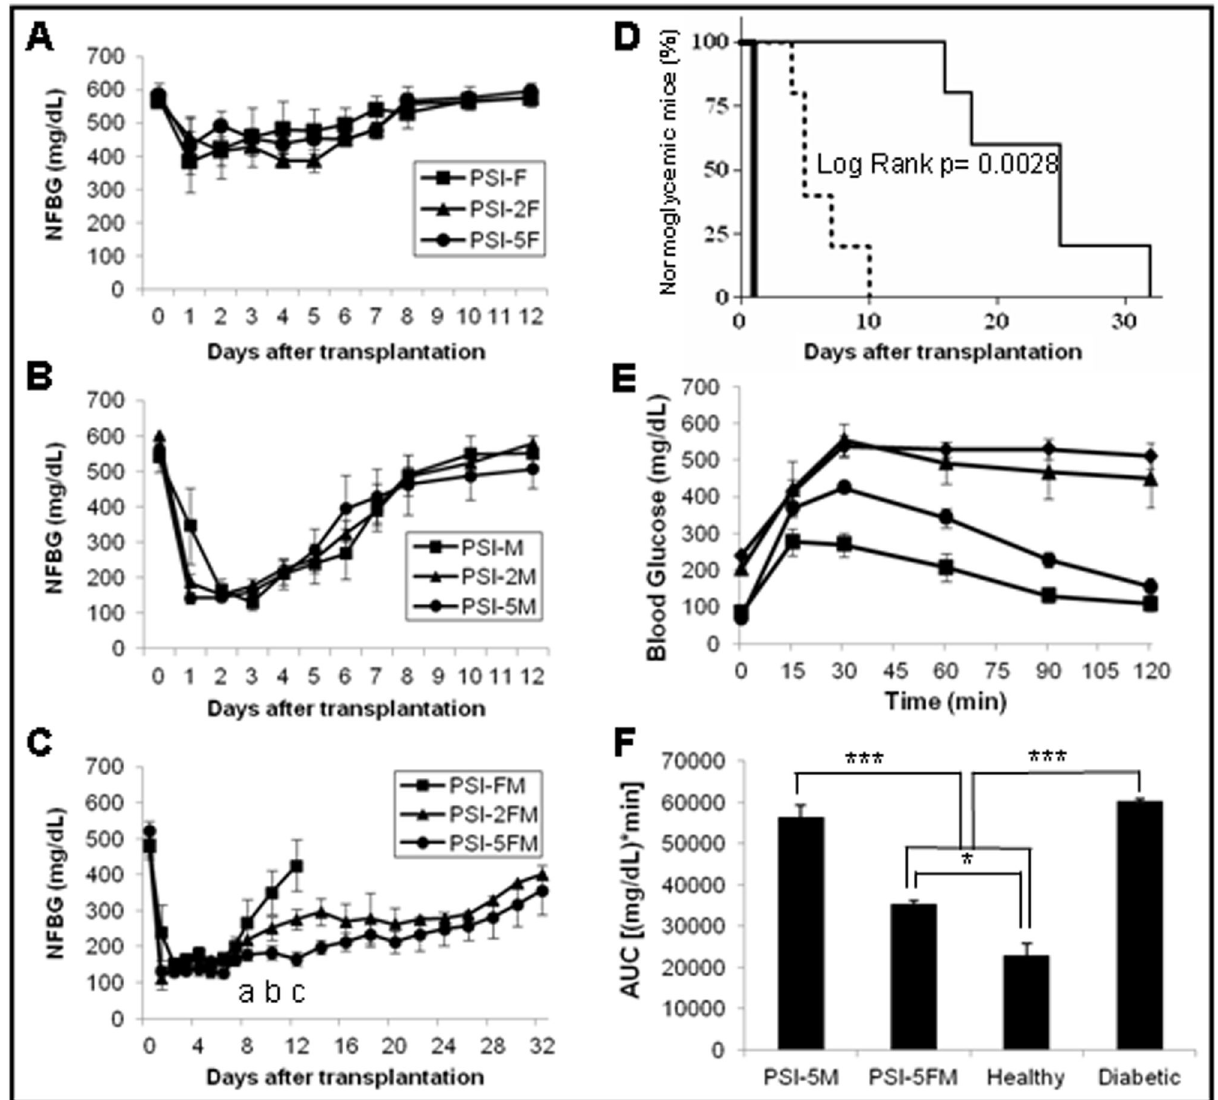
Figure 2. Subcutaneous transplantation of PSI in immunocompetent diabetic mice. A) Follow up of NFBG in mice subcutaneously transplanted with PSI containing three different cell doses of autologous fibroblasts: 2 x 10 5 (PSI-F, n=5), 4 x 10 5 (PSI-2F, n=5) and 1 x 10 6 (PSI-5F, n=7). B) Follow up of NFBG in mice subcutaneously transplanted with PSI containing three different cell doses of allogenic BM-MSCs: 2 x 10 5 (PSI-M, n=5), 4 x 10 5 (PSI-2M, n=5) and 1 x 10 6 (PSI-5M, n=7). C) Follow up of NFBG in mice transplanted with PSI containing three different cell doses of both autologous fibroblasts and allogenic BM-MSCs: 2 x 10 5 (PSI-FM, n=5), 4 x 10 5 (PSI-2FM, n=5) and 1 x 10 6 (PSI-5FM, n=7). All results are expressed as mean ± SEM. Statistical significances (p<0.05): ( a ) PSI-5FM vs PSI-FM and PSI-2FM; ( b ) between the three groups; ( c ) PSI-2FM vs PSI-5FM. D) Percentage of animals with normoglycemia after transplantation. Thick line, PSI-5F; dotted line, PSI-5M; thin line, PSI-5FM. E) Blood glucose responses to IPGTTs performed 7 days after transplantation in the following groups of diabetic mice: (♦), non-transplanted; (▲), PSI-5M; (●), PSI-5FM; (■), non-transplanted healthy mice. For all groups n=7. F) AUC data obtained from IPGTTs. (*) p<0.05; (***) p<0.001.